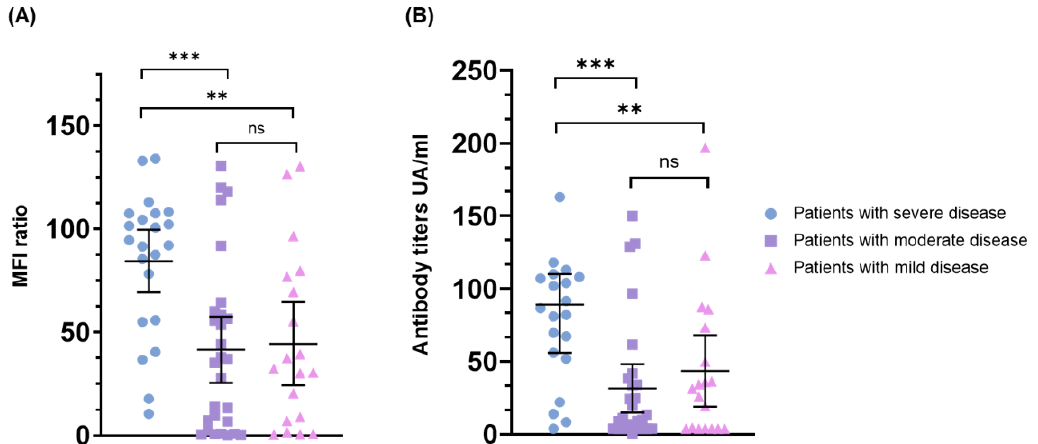
Figure 3. The antibody titers at admission according to clinical stratification. Panel ( A ) Luminex assay, panel ( B ) CLIA. Scatter plot with lines at the median and whiskers showing the 95% confidence interval (CI). *** = p < 0.001, ** = p < 0.01, ns = non-significant, MFI = median fluorescence intensity.